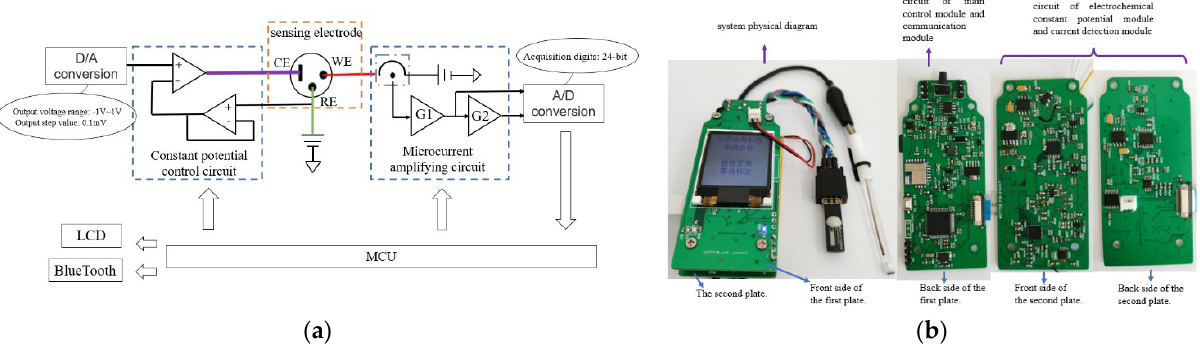
Figure 2. Portable heavy-metal-ion sensor detection system: ( a ) system block diagram; ( b ) picture of the detection circuit